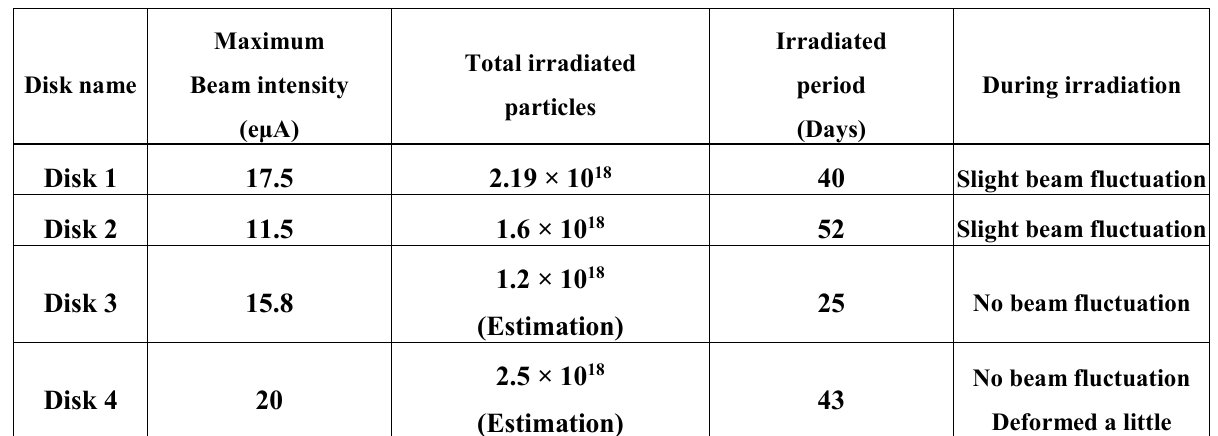
Table 2. Summary of the results of 4